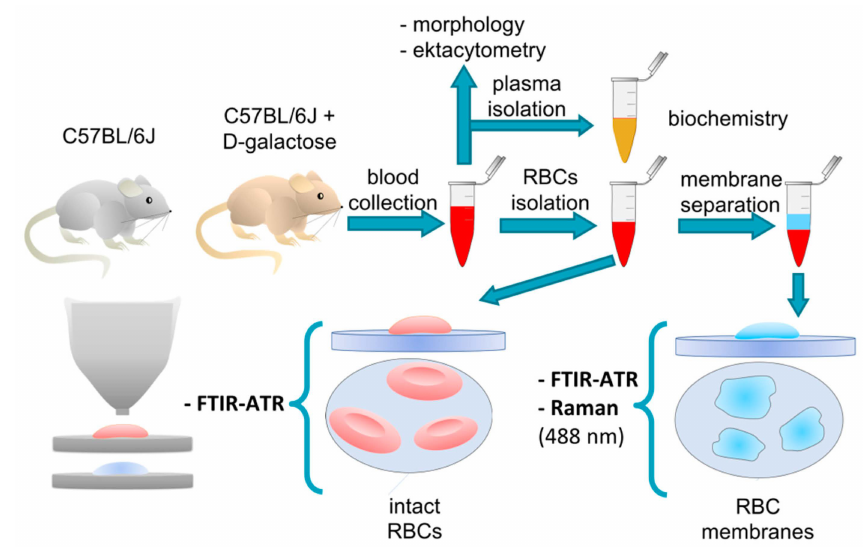
Figure 5. A schematic of the performed